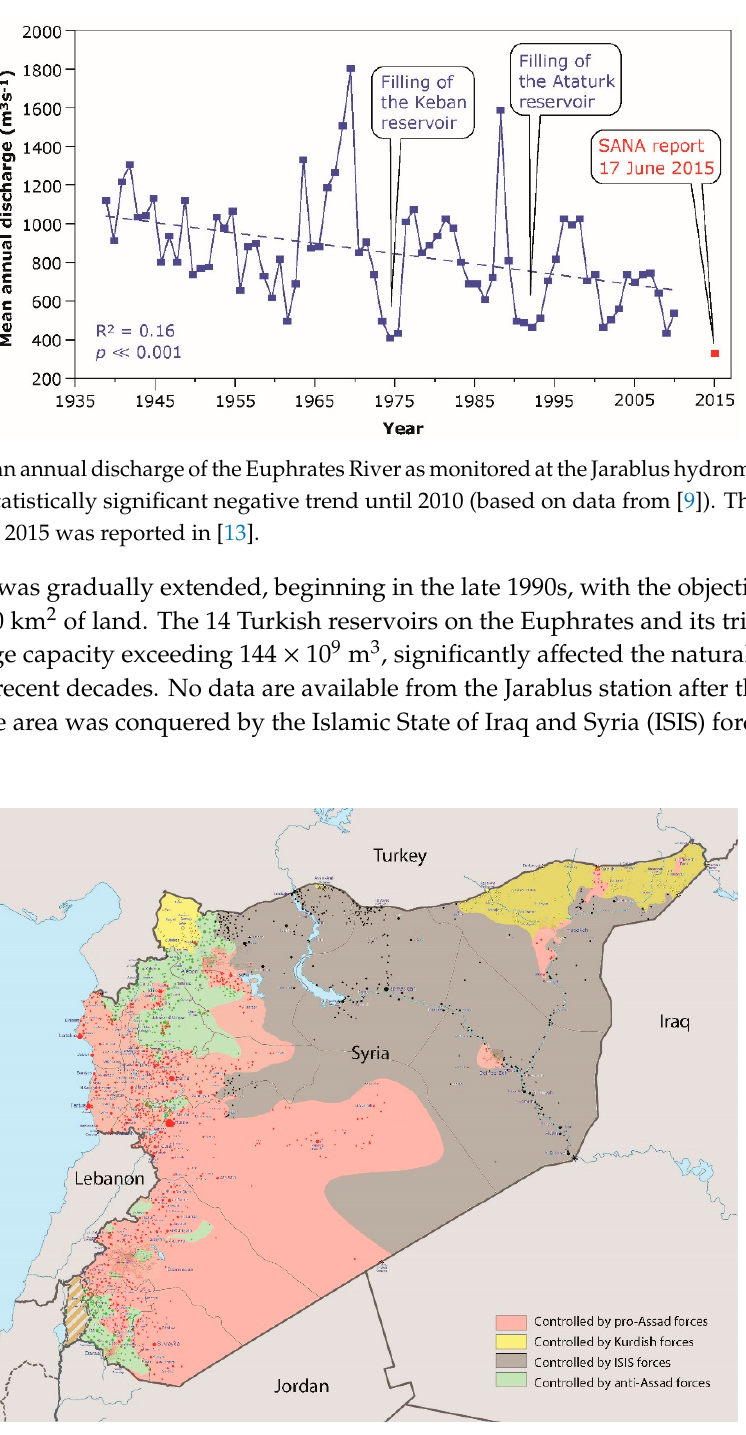
Figure 3. The territorial control map of the Syrian Civil War as of 24 November 2014 (reproduced from Wikimedia Commons, https://upload.wikimedia.org/wikipedia/commons/6/60/Syrian_civil_war_24-11-14.png).